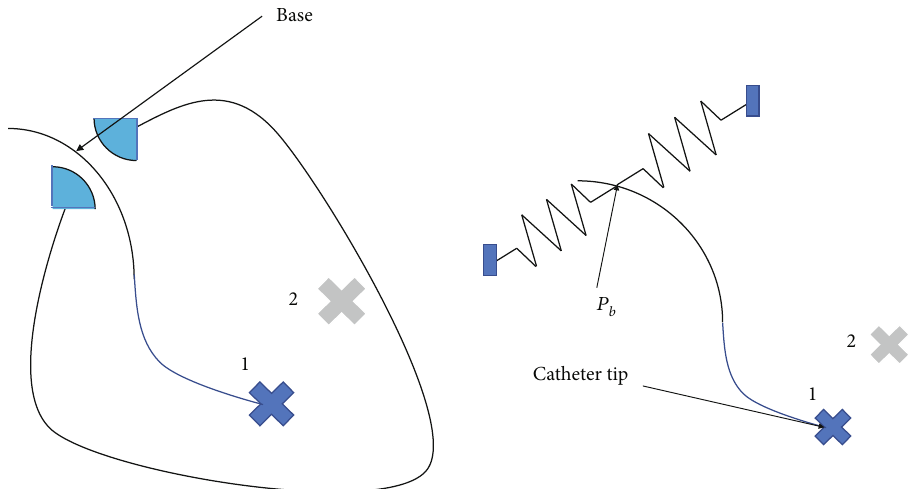
Figure 4: The safe interaction with the texture modeled by the